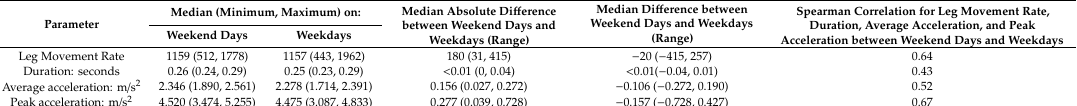
Table 6. Leg movement rate, duration, average acceleration, and peak acceleration of leg movements on weekends versus weekdays.